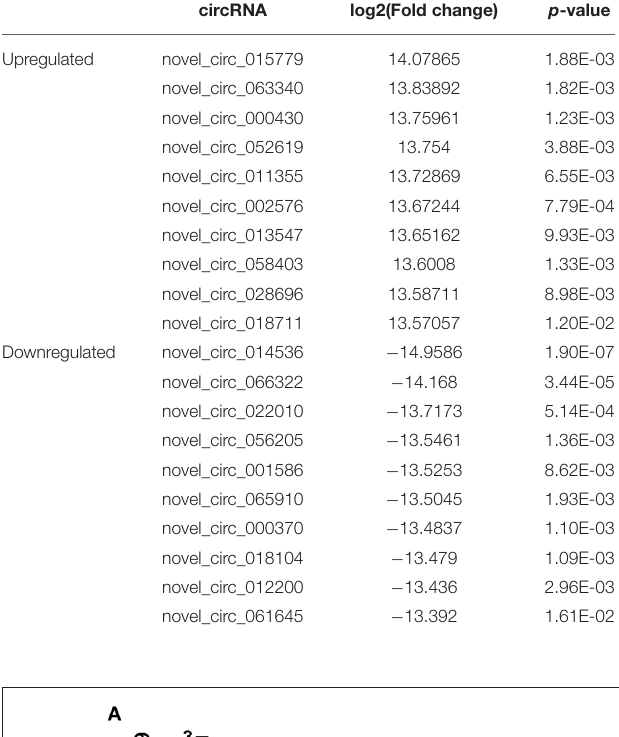
TABLE 1 | Biological information regarding the top 10 upregulated and downregulated circRNAs in autism mouse model. circRNA log2(Fold change) p -value